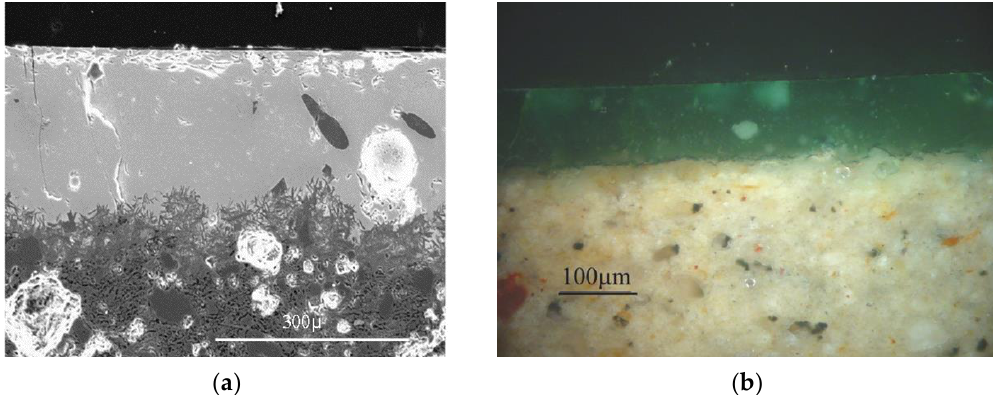
Figure 5. Monochrome colored glazes: ( a ) Secondary electron-SEM image of monochrome coating where a great interface between glaze and ceramic body can be observed; ( b ) Optical Microscopy image of a green glaze.